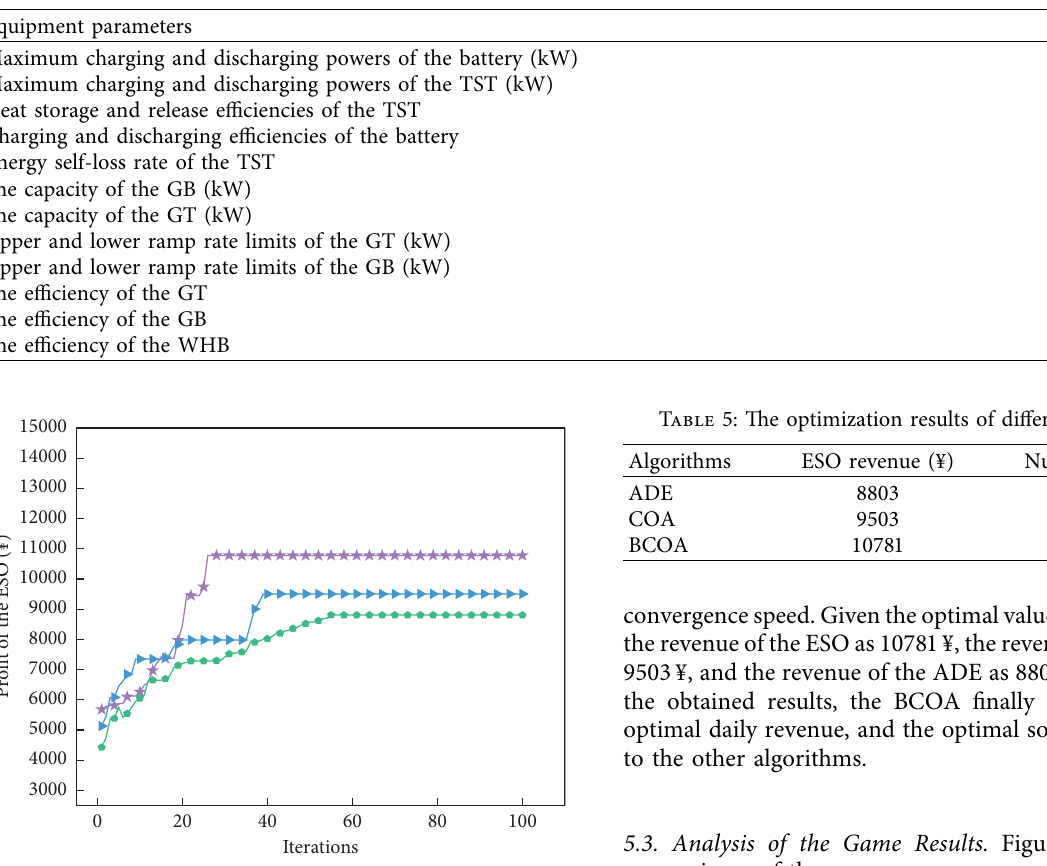
Figure 6: Te curve of the power prediction. Table 4: Te operation parameters for each type of equipment.